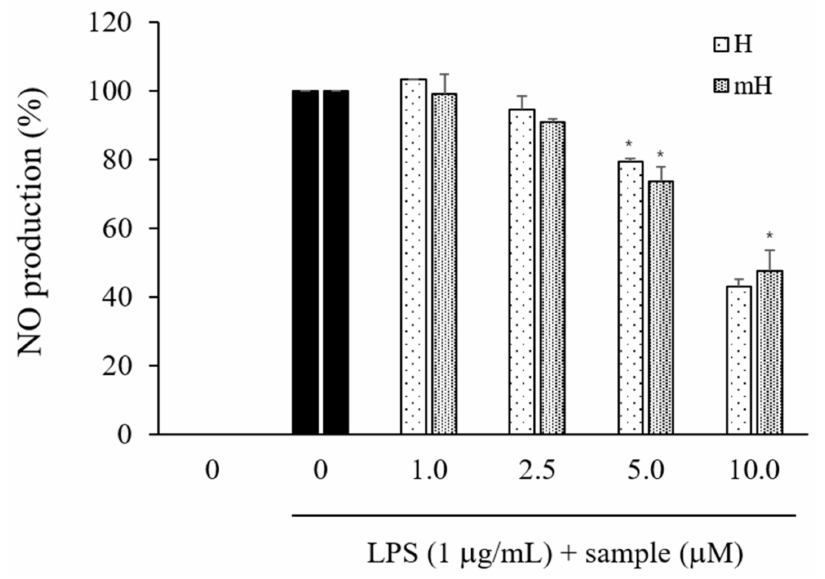
Figure 4. Effects of H and mH on NO production in LPS-induced RAW 264.7. Cells were cultured in the presence of H and mH for 1 h and stimulated with LPS (1 µ g/mL) for 24 h under serum-free conditions. NO production was determined using Griess reagent. Nitrite concentrations of nontreated and LPS-treated controls were 4.63 ± 1.48 µ M and 30.35 ± 0.12 µ M, respectively. Each determination was made in triplicate. Data are presented as means ± SD. * p < 0.05 vs. LPS-treated